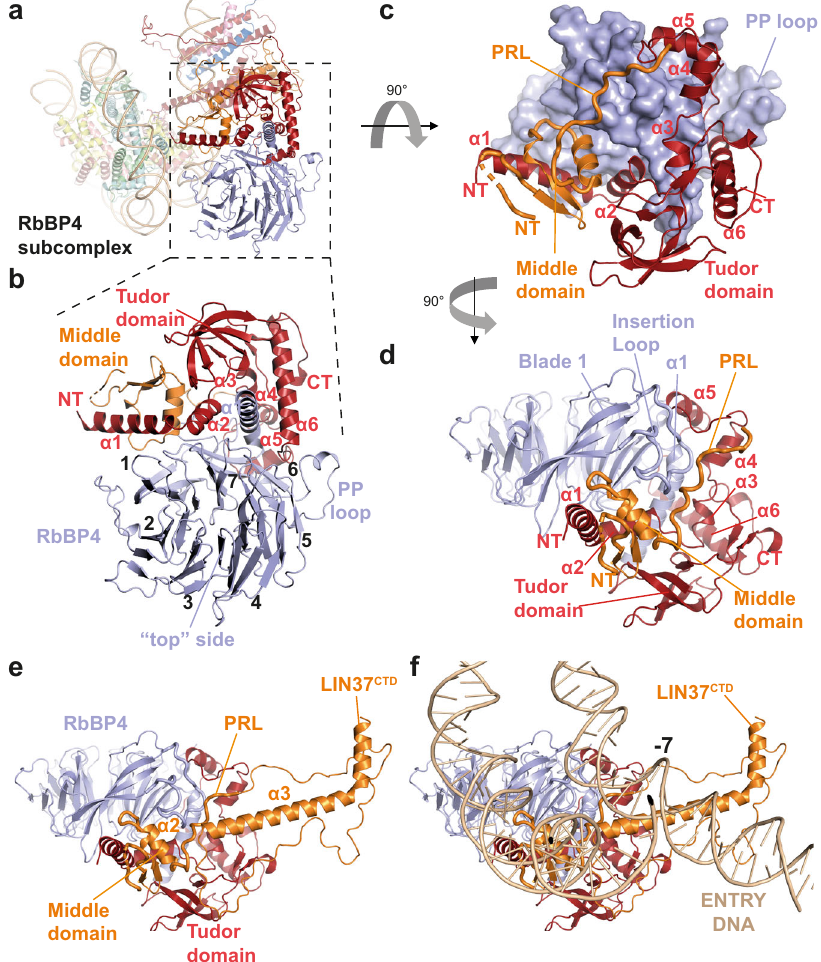
Fig. 2 | Architecture and assembly of the MuvB HEAD complex. a – d Cartoon representation showing the structure of the RbBP4 subcomplex. The position of this complex in relation to the entire model is illustrated in ( a , b ). Blades of the RbBP4 WD40 domain are numbered in ( b ). RbBP4 is shown is surface